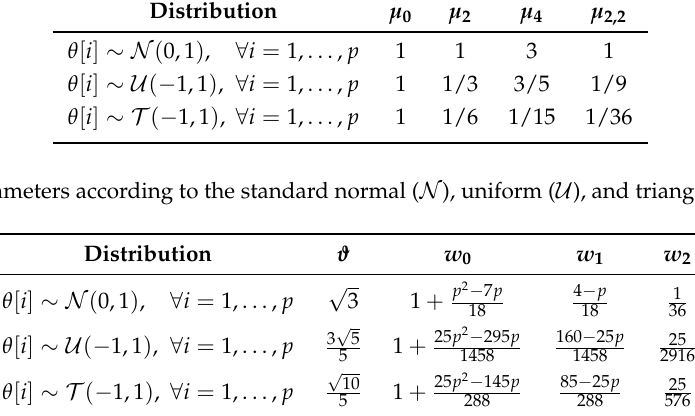
Table 1. Statistical central moments of the standard normal ( N ), uniform ( U ), and triangle ( T ) distribution. Distribution